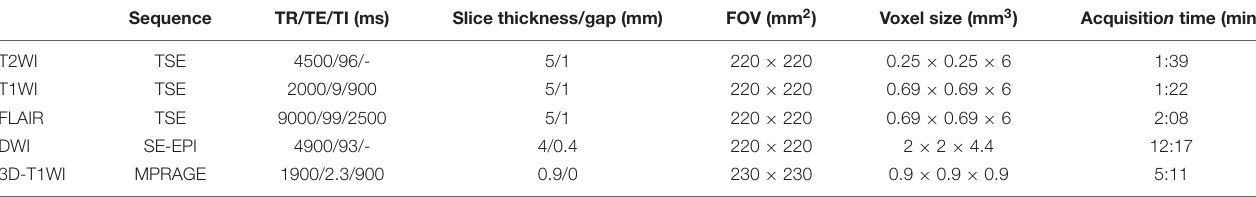
TABLE 2 | Imaging sequences and acquisition parameters of